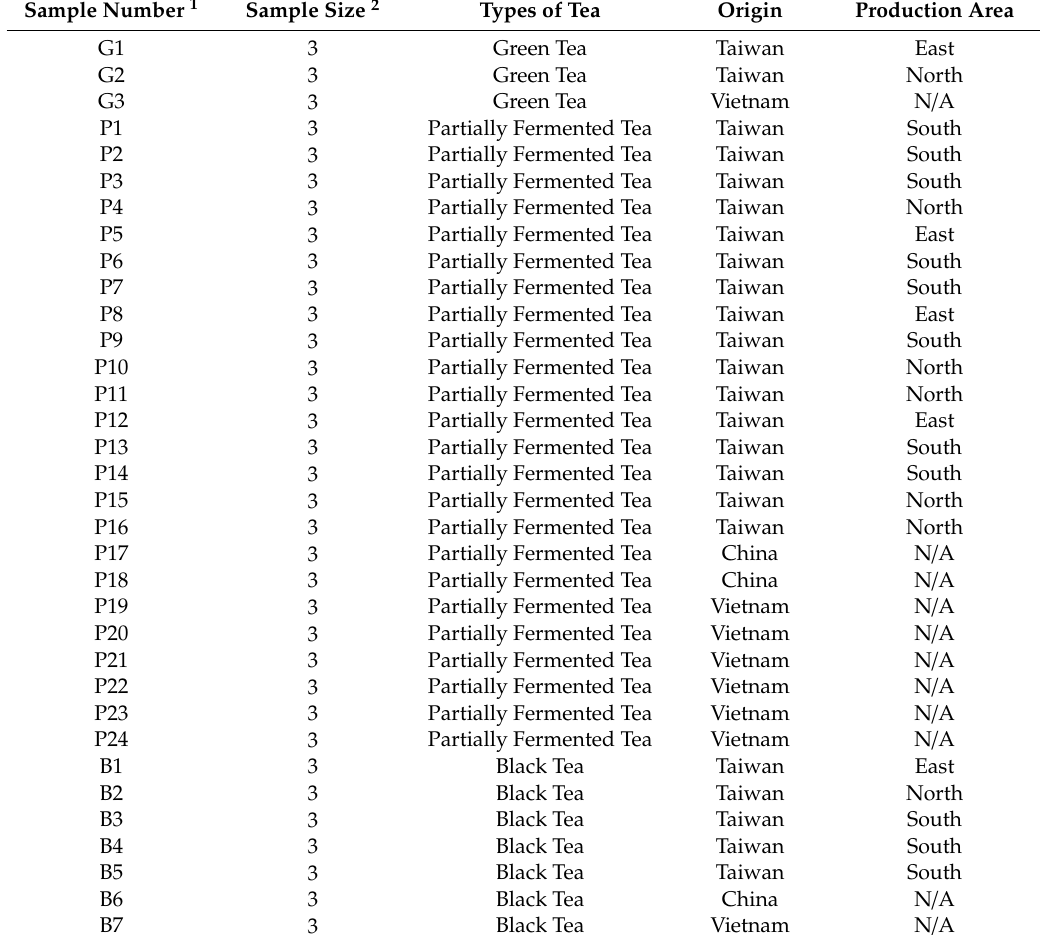
Table 1. The origins of the green, partially fermented, and black tea samples from Taiwan, Vietnam, and